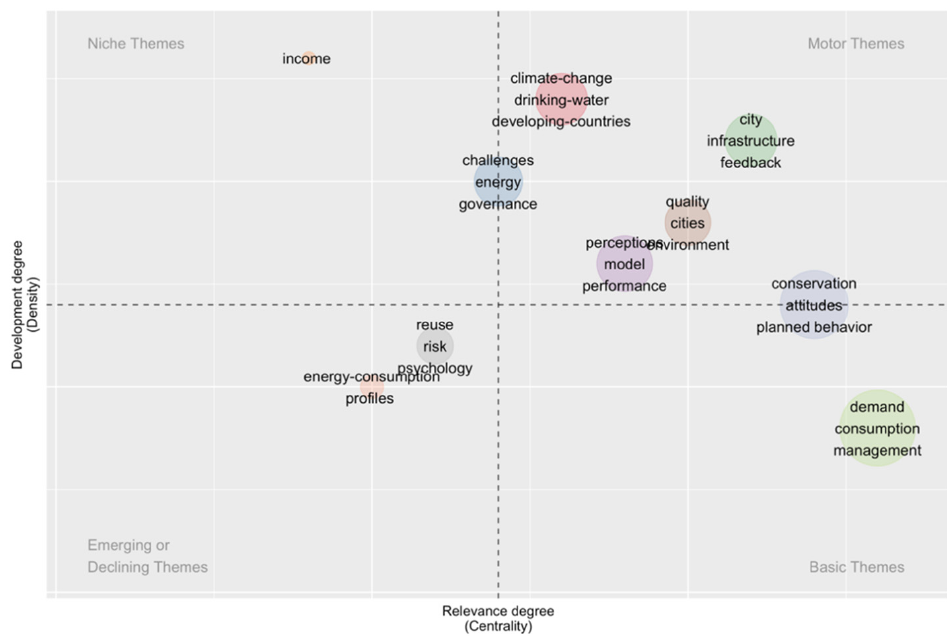
Figure 4. Strategic